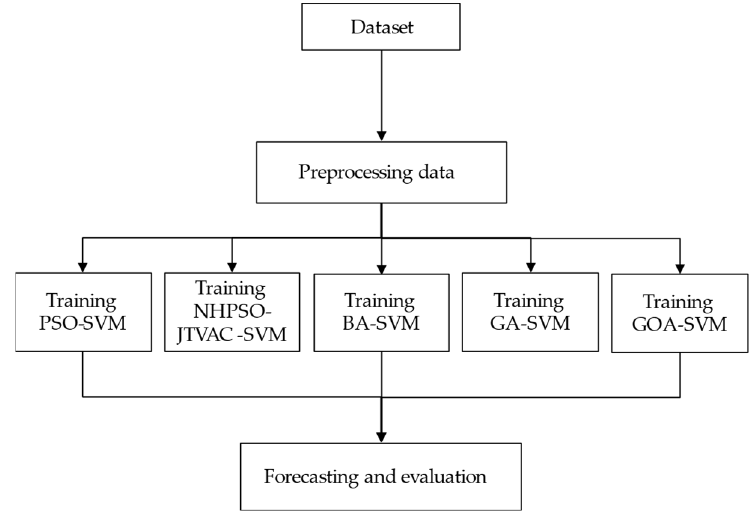
Figure 5. Flow chart of feature selection.